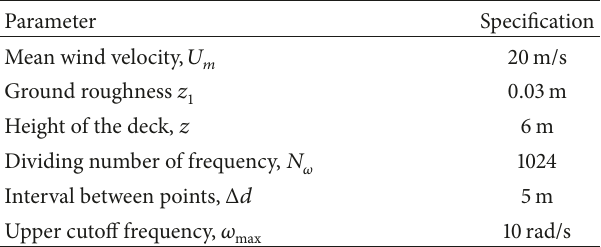
Table 5: Parameters for simulating wind